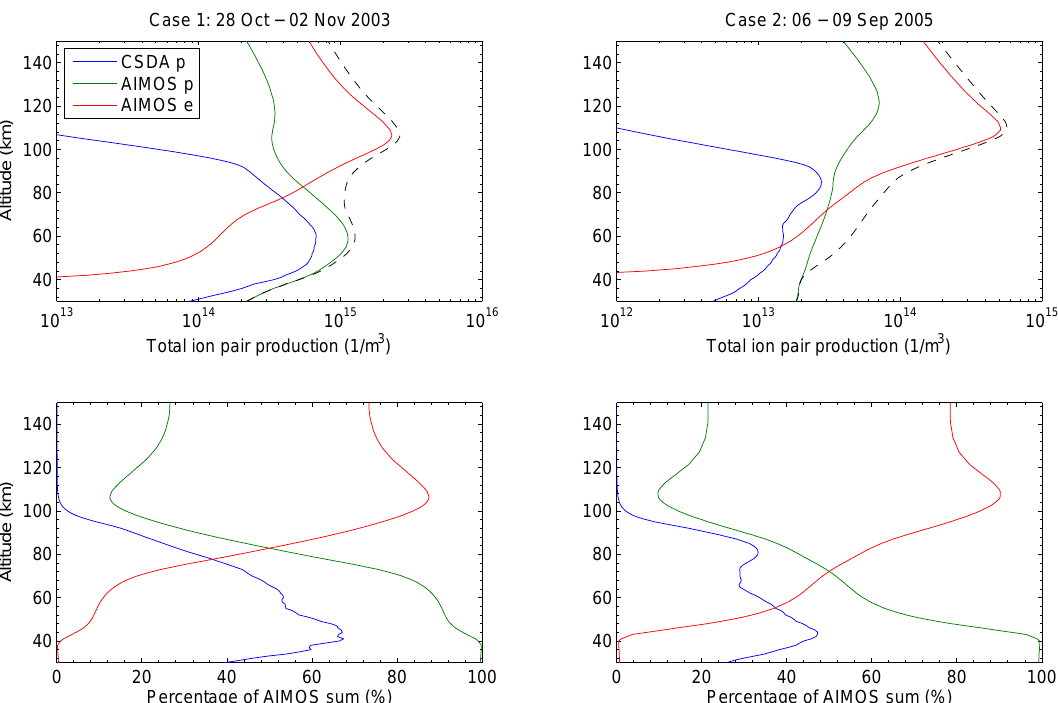
Figure 1. Top: integrated ion–electron pair production by CSDA (protons only) and AIMOS (protons and electrons separately). The dashed black line is the sum of AIMOS (protons and electrons). Bottom: relative proportion compared to the AIMOS sum.